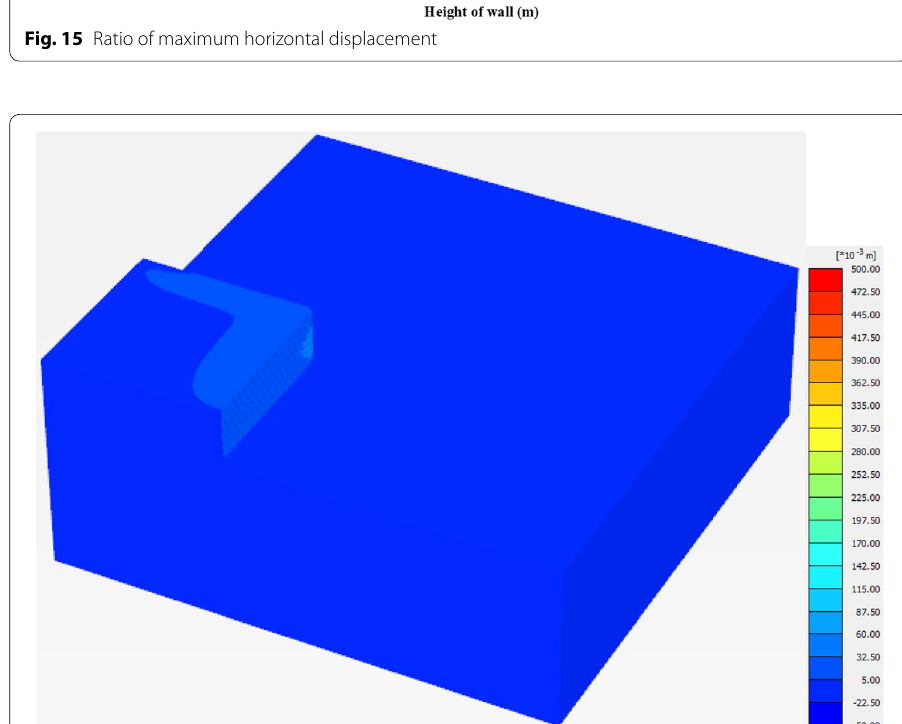
Fig. 16 Horizontal displacement contour of Case